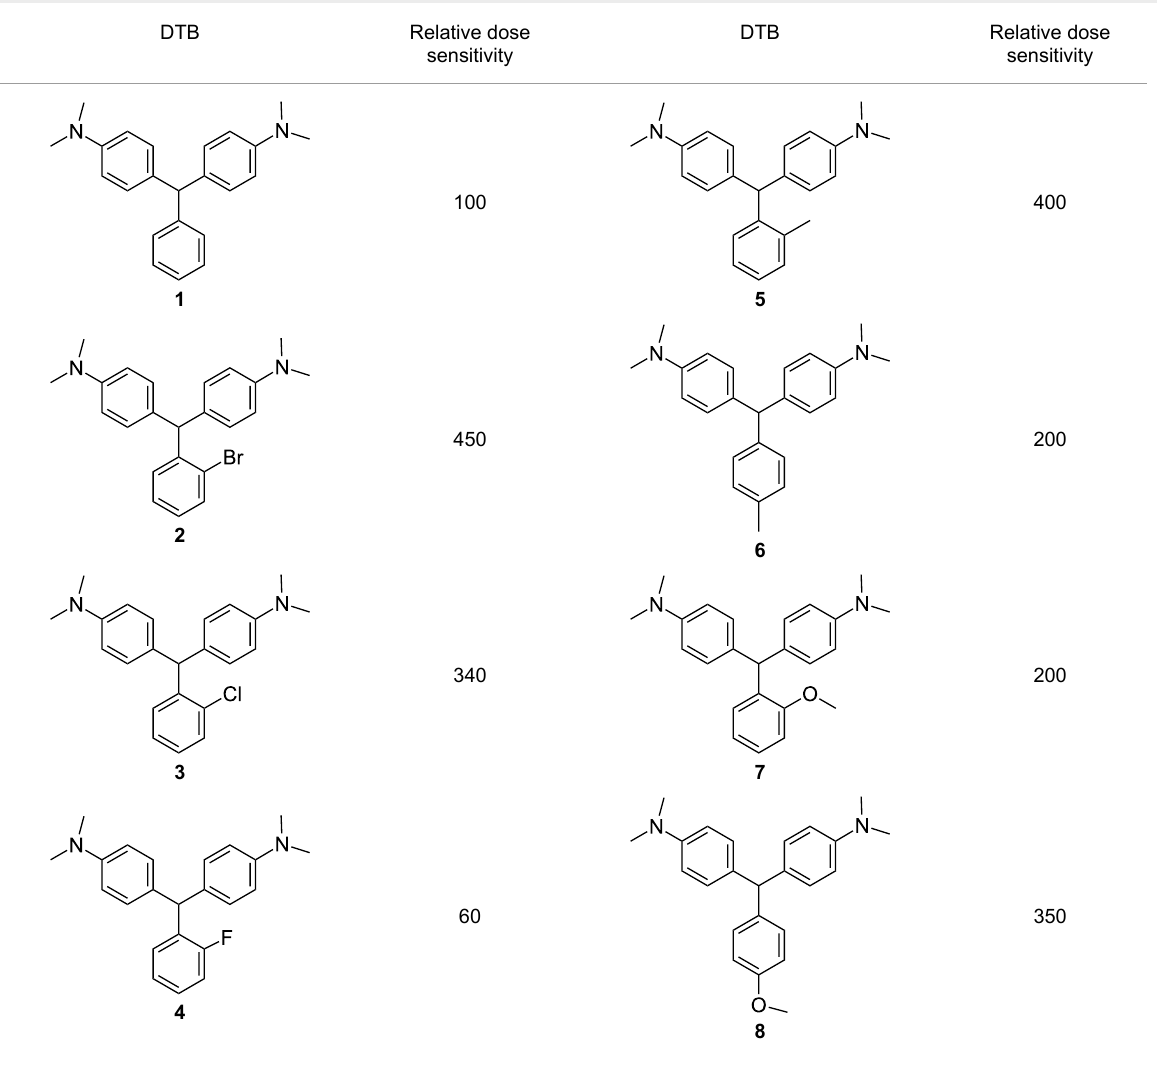
Table 1: Synthesized DTBs and their LMG ( 1 ) relative radiation dose